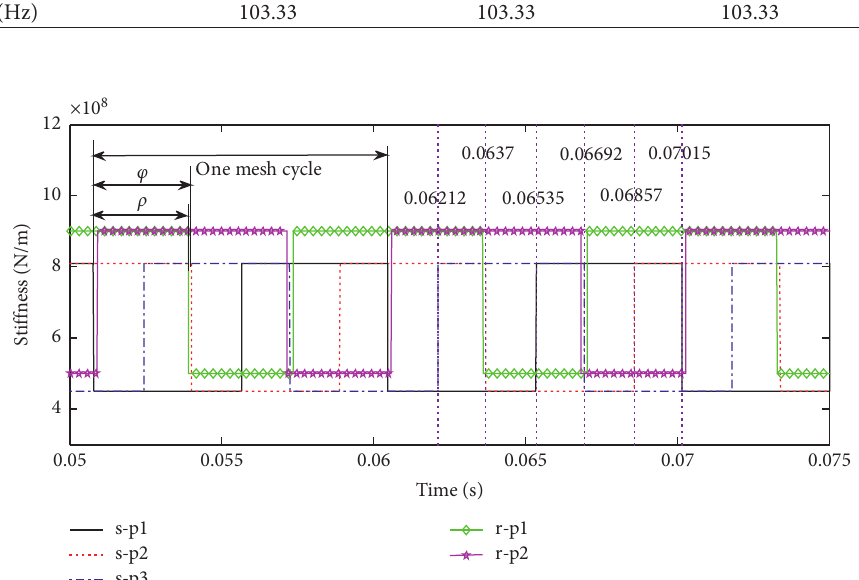
Figure 7: Meshing stiffness of different planets with the sun gear and ring gear.